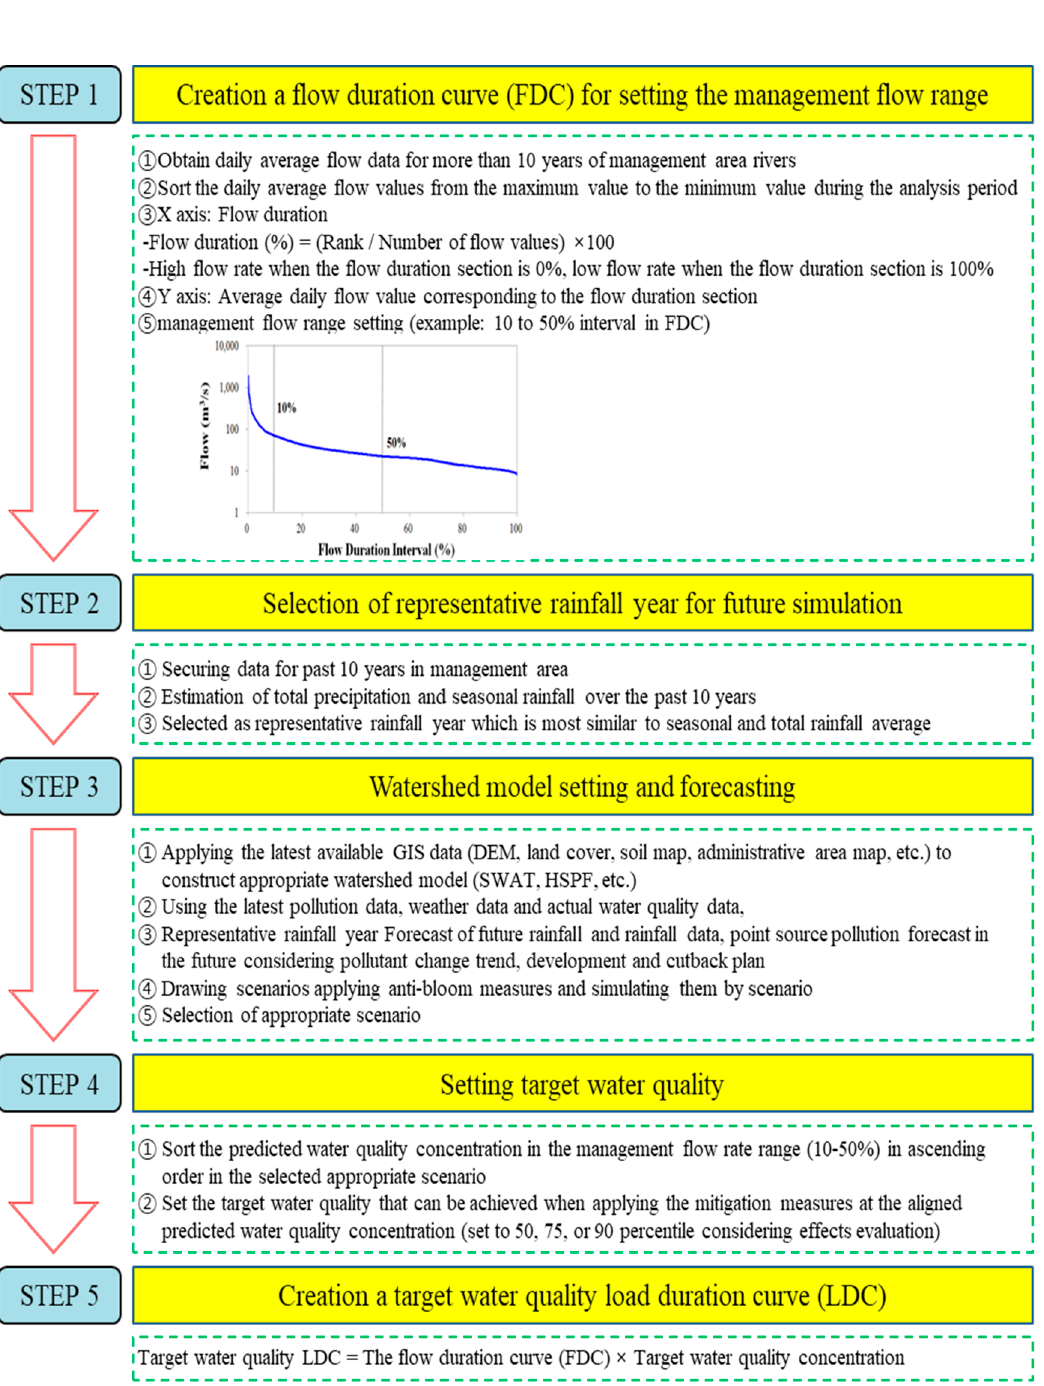
Figure 10. Setting the management water quality target and creating the load duration curve (LDC).